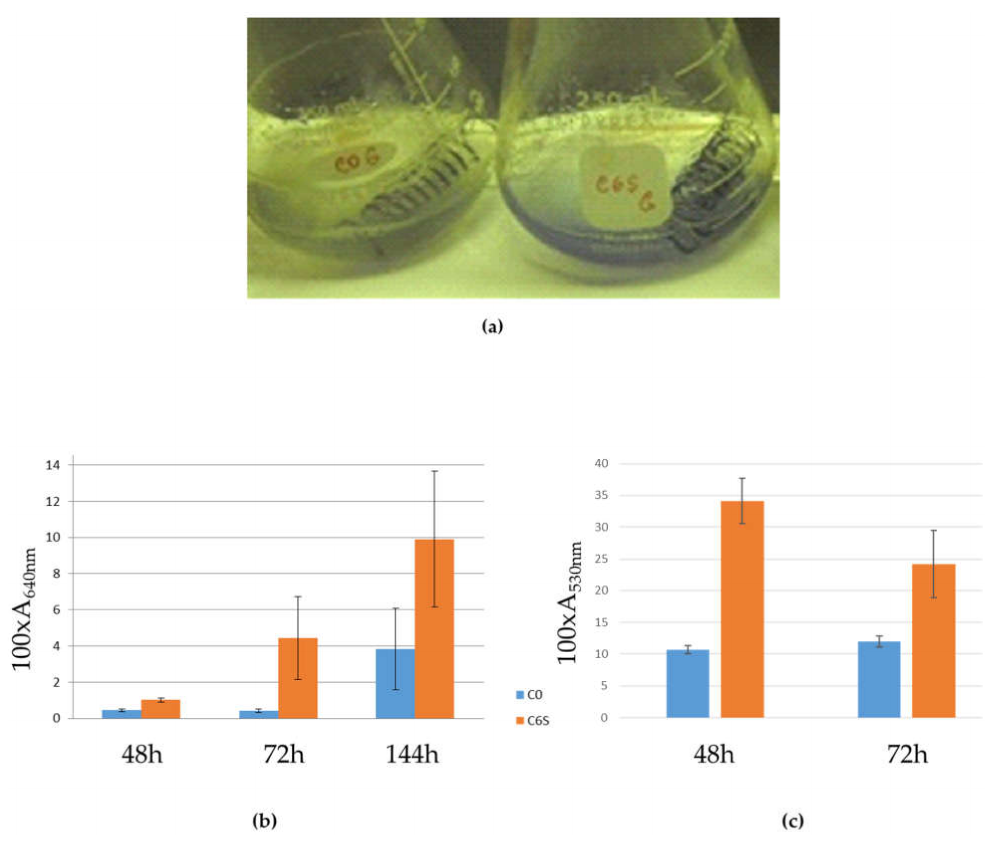
Figure 4. Liquid culture phenotypes: ( a ) The C0 control (left) and C6S (right) strains after 72 h of cultivation in NMMP liquid medium. ( b ) Comparison of actinorhodin production in C0 and C6S strains; the y -axis indicates absorbance at A 640 × 100 and normalized per cell concentration. The error bars represent a confidence interval from at least four independent biological replicates ( α = 0.2). ( c ) Comparison of undecylprodigiosin production in C0 and C6S strains; the y -axis indicates absorbance at A 530 × 100 and normalized per cell concentration. The error bars represent a confidence interval from at least three independent biological replicates ( α =